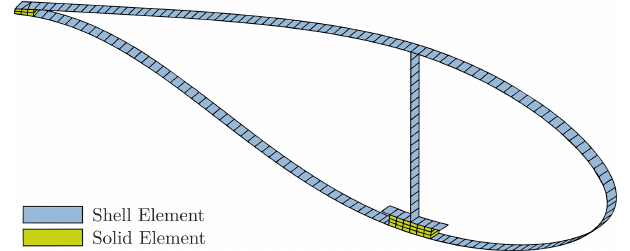
Figure 6. Cross-sectional cut of the FE model at r = 8m ( r norm =